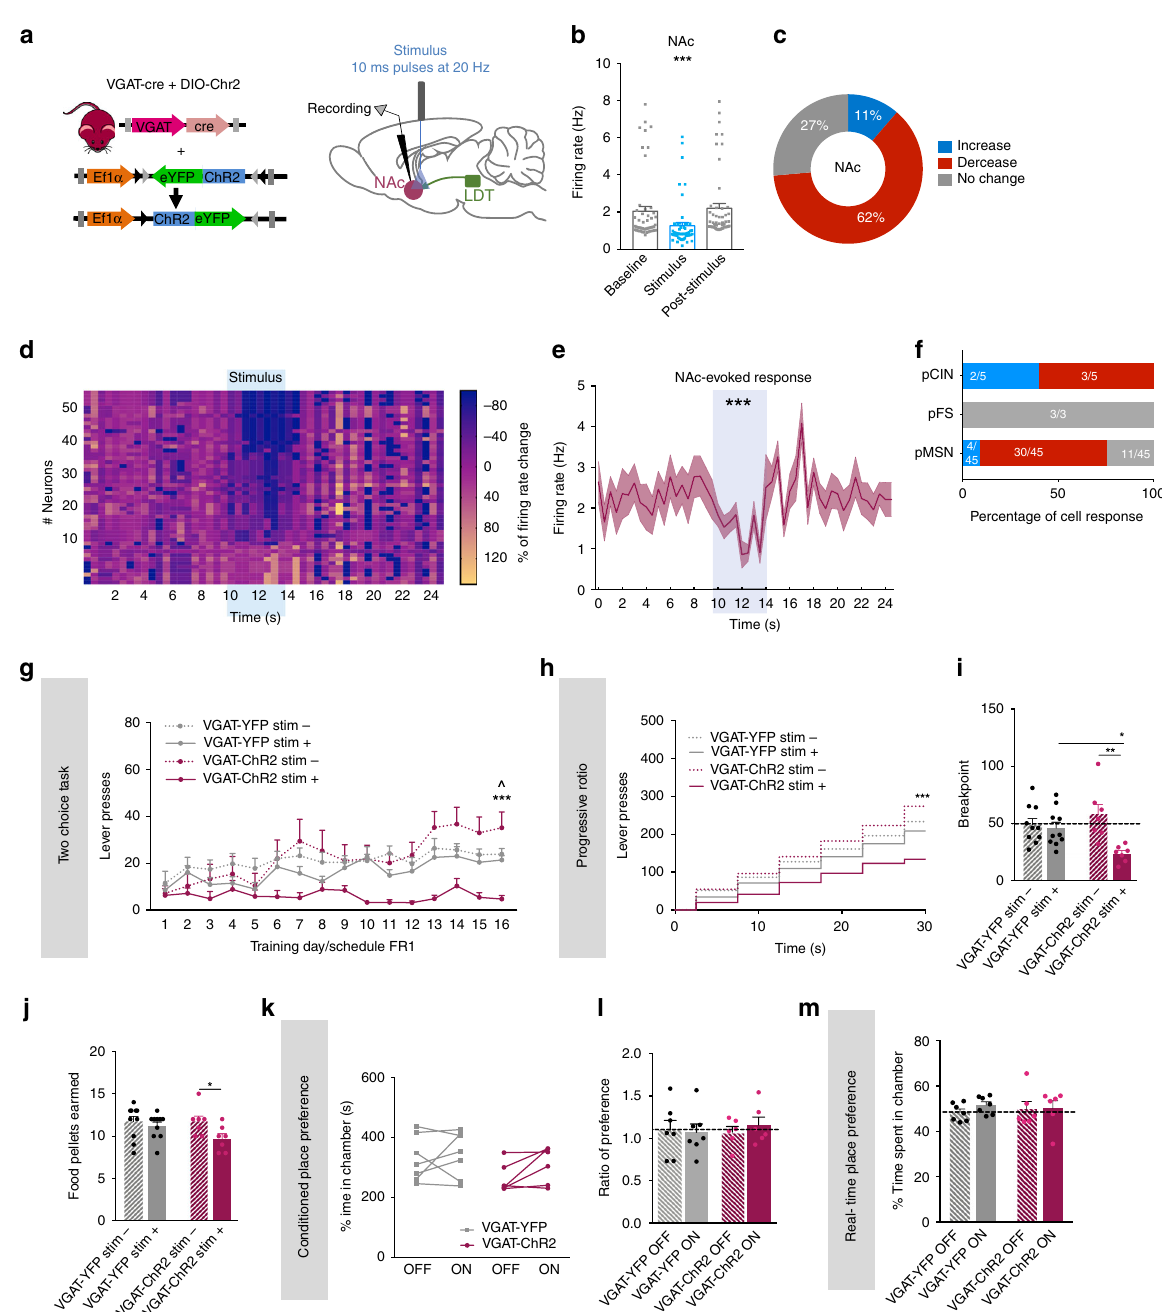
Fig. 6 Selective activation of LDT-NAc GABAergic inputs during reward-related behaviors. a Strategy used for optogenetic manipulation of LDT glutamatergic terminals in the NAc. DIO-ChR2 was injected in the LDT of VGAT-cre mice, and optical stimulation was performed in the terminals in the NAc. b Stimulation of GABAergic terminals decrease NAc net fi ring rate ( n = 6 animals; 53 cells; RM 1way ANOVA). c The majority of NAc cells decreased the fi ring rate during stimulation, 27% presented no change and 11% increased activity. d Heatmap representation of percentages cell responses in the NAc upon stimulation of GABAergic terminals. e Average fi ring rate of NAc neurons showing a decrease in activity from the baseline during optical inhibition (KS test). f Percentage of responses of each NAc cell type to GABAergic LDT terminal activation. g Time-course representation of the responses during the two-choice task of VGAT- ChR2 ( n = 7) and VGAT-YFP ( n = 10) mice on stim + and stim- lever. VGAT-ChR2 animals prefer the stim- over stim + lever; no preference is observed in VGAT-YFP animals. h Cumulative presses performed during the progressive ratio task, showing increased presses in stim- lever in VGAT-ChR2 animals. i Breakpoint for stim + lever is decreased in VGAT-ChR2 animals, indicative of decreased motivation for the laser-paired reward. j Number of pellets earned during progressive ratio sessions. k Total time spent in ON and OFF chambers in the CPP ( n VGAT-ChR2 = 6, one animal lost cannula; n VGAT-YFP = 7, four animals lost cannula). l Ratio of preference between ON and OFF chambers in the CPP test, showing no differences between groups. m Percentage of time spent in each side of the RTPP, showing no differences between groups. Values are shown as mean±s.e.m. *refers to difference between VGAT-ChR2 stim + and stim- lever, RM 2way ANOVA; ^refers to difference between VGAT-ChR2 stim + and VGAT-YFP stim + lever; RM 2way ANOVA. * p <0.05; ** p <0.01; *** p